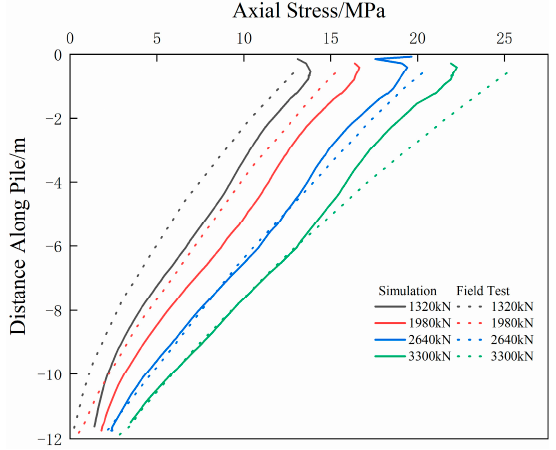
Figure 7. Simulation and test results of axial stress along the stiffened core.